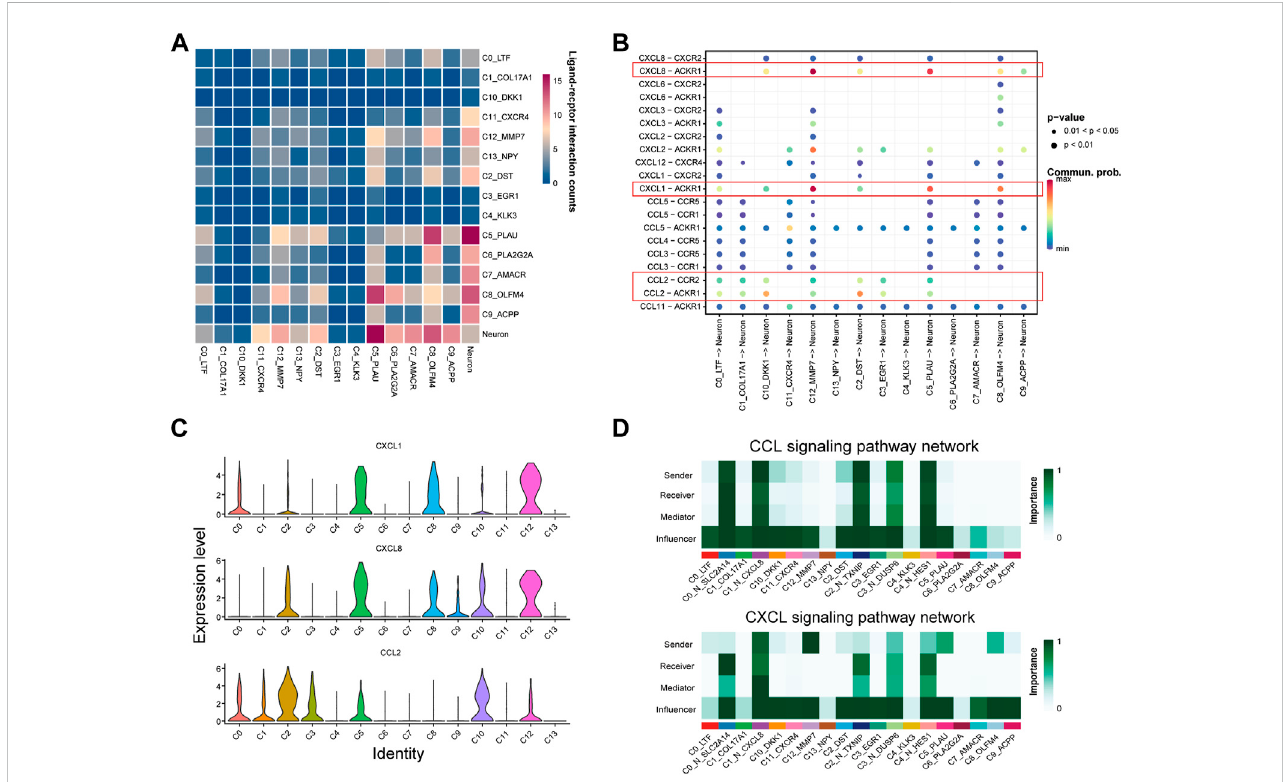
FIGURE 4 Cell interaction networks in PNI-PCa. (A) Heatmap shows the number of potential ligand-receptor pairs between epithelial cell subtypes and neural cell sells predicted by Cellphone DB. The more red the color, the stronger cell-cell communication. (B) Bubble plot of ligand-receptor interactions between epithelial cell subtypes and neural cells, where the bubble size represents the p -value (the p -value of all bubbles is less than .05), the bigger the bubble, the smallerthe p -value.Thecolorrepresentscellinteractionstrength,theredderthecolor,thestrongertheinteraction. (C) Barchartshowingtheexpression levels of CCL2, CXCL1, and CXCL8 in each epithelial cell subgroup. (D) The communication probability of neural and epithelial cells on the CXCL and CCL signaling